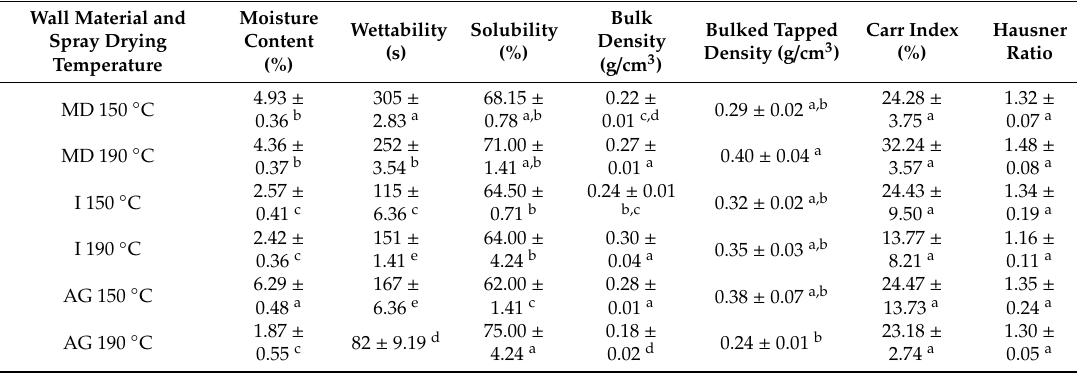
Table 2. Properties of powders with encapsulated pineapple peel extract produced with di ff erent wall materials and spray drying temperature conditions: MD, maltodextrin; I, Inulin; and AG, arabic gum. Di ff erent lower-case letters in the same column show statistically significant di ff erences among values ( p <